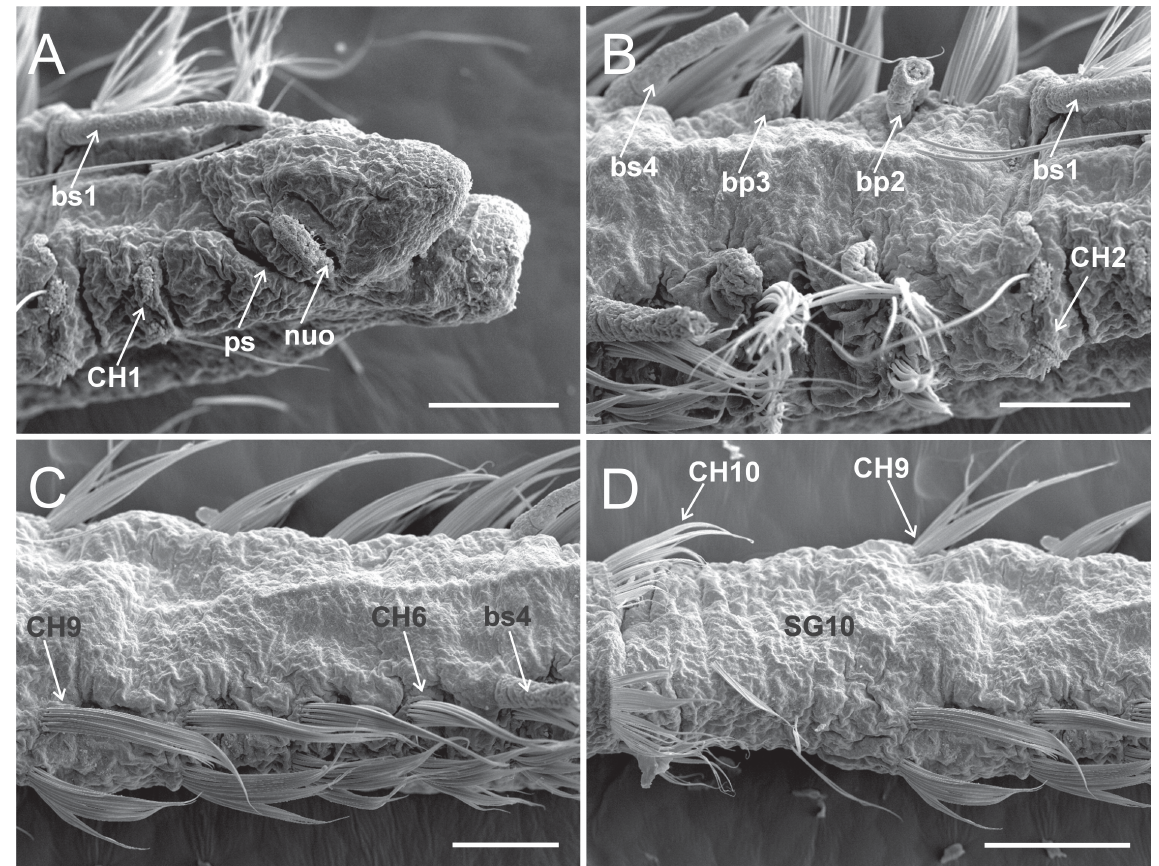
Fig. 4. Heterospio indica sp. nov., paratype (MNCN 16.01/17000), SEM micrographs. A . Anterior end, dorsolateral view (scale bar = 100 m m). B . CH2–CH5, dorsal view (scale bar = 100 m m). C . CH5–CH9, dorsal view (scale bar = 100 m m). D . CH8–CH10, dorsal view (scale bar = 15 m m). Abbreviations: bp = branchiophore; bs = branchiostyle; CH = chaetiger; nuo = nuchal organ; ps = palp scar; SG =